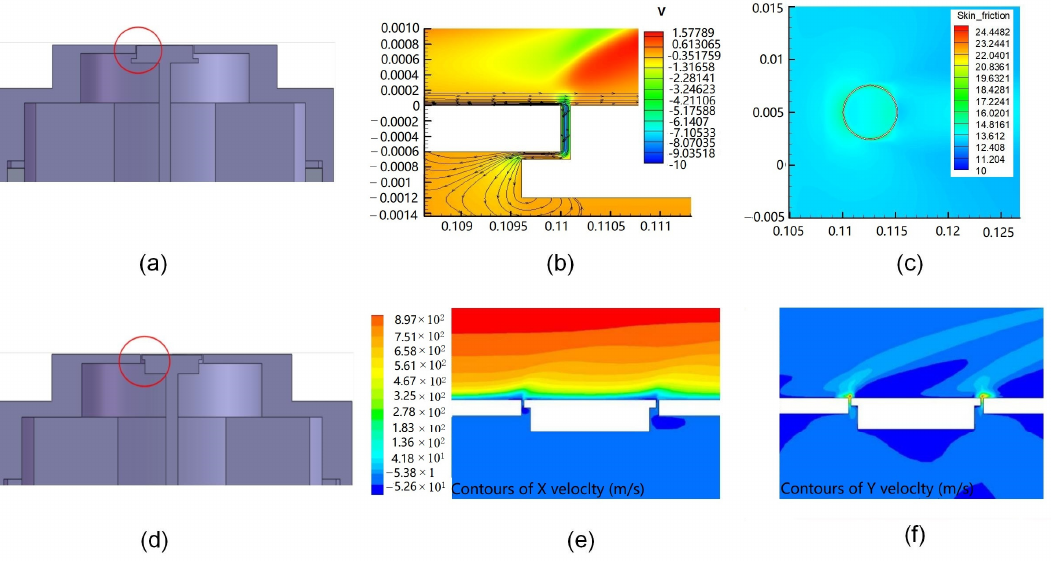
Figure 3. ( a ) The structure of the floating element in our previous work; ( b ) the 2D streamline diagram in the friction sensor; ( c ) the skin friction coefficient of the flat plate; ( d ) the optimized structure of two-layer floating element; ( e ) the velocity distributions in the X direction at floating element under a total pressure of 1.5 MPa; ( f ) the velocity distributions in the Y direction at floating element.